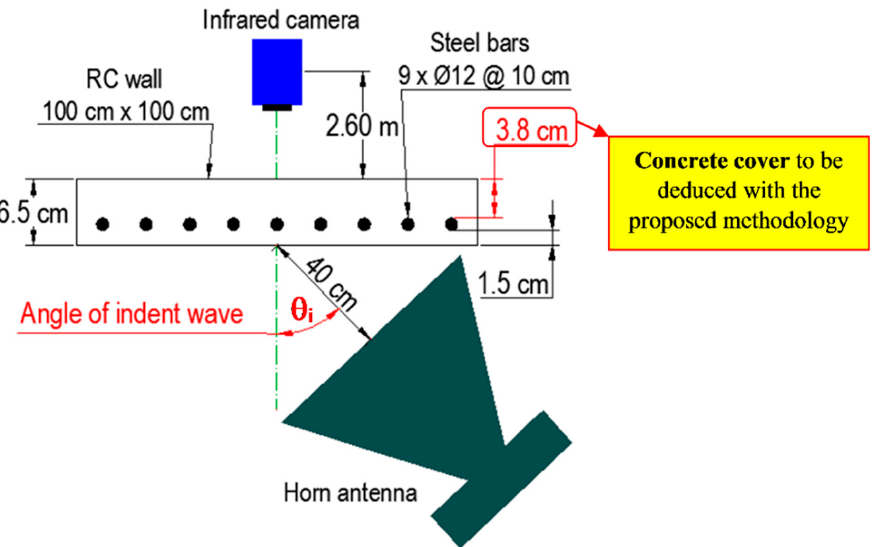
Figure 4. Experimental setup of the detection of RC wall by microwave thermography with transmission approach.